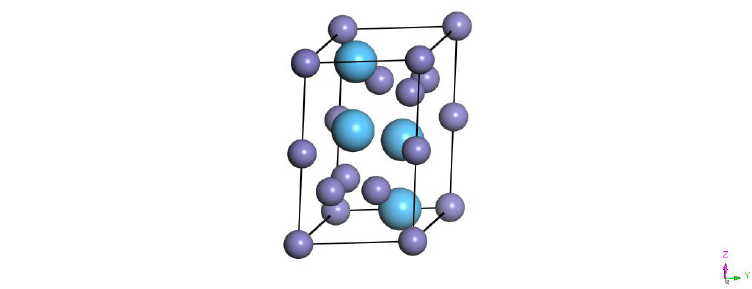
Fig. 1. Unit-cell of Fe 2 Hf cubic and hexagonal crystal, the large and small balls represent Hf and Fe atoms,